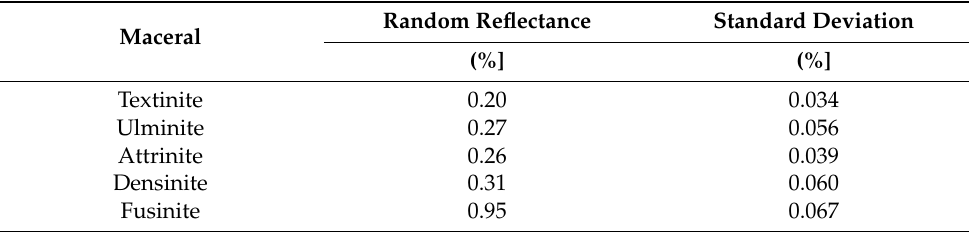
Table 2. Random reflectance of selected macerals in lignite from the Szczerc ó w deposit.